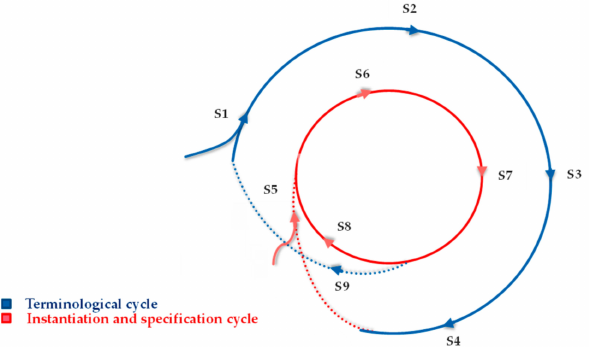
Figure 2. Proposed workflow methodology for training Toolkit implementation in Smart